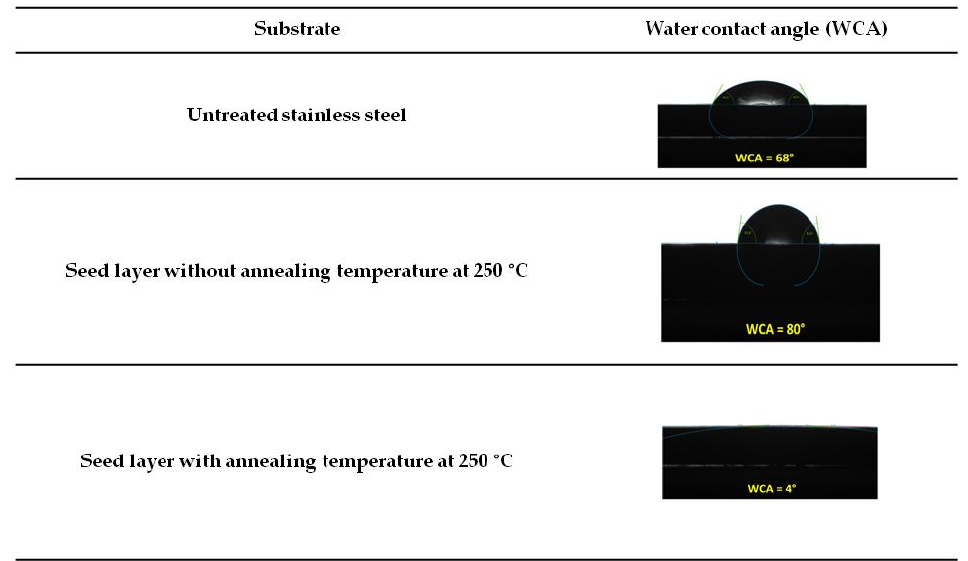
Figure 6. Contact angles of untreated stainless steel, ZnO Seeds deposited on stainless steel with and without annealing at 250 °C.